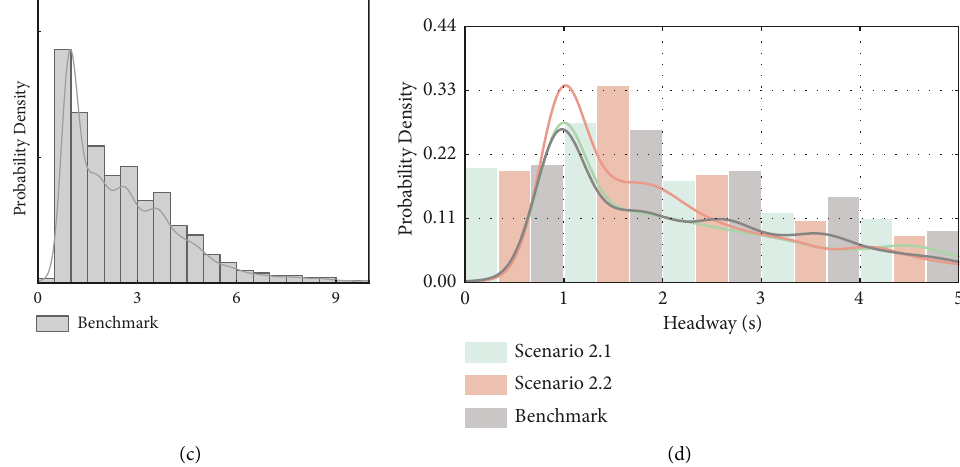
Figure 10: The results for the second simulation under the headway: (a) the probability density of the headway in scenario 2.1, (b) the probability density of the headway in scenario 2.2, (c) the probability density of the headway in the benchmark scenario, and (d) the comparison of the three scenarios under the headway.